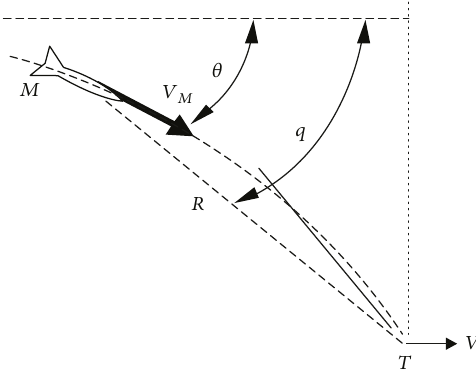
Figure 1: Two-dimensional engagement